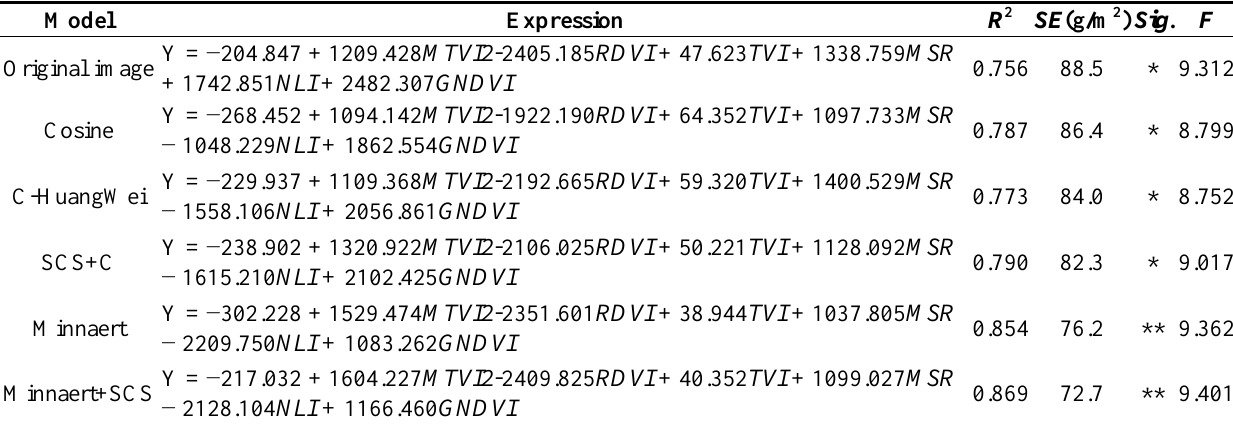
Table 7. Model Statistics and Analysis of Variance (ANOVA ☉ )